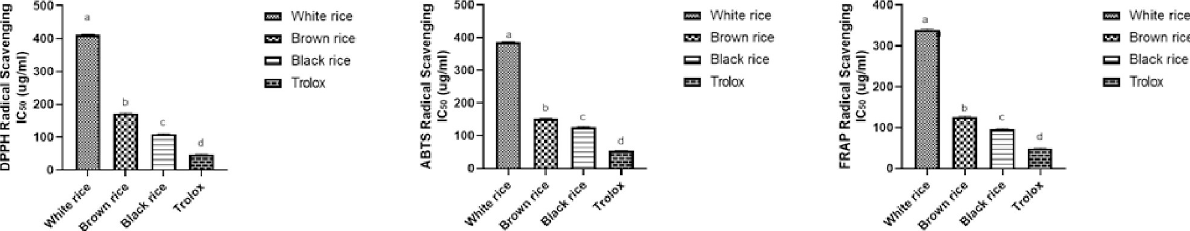
Fig 1. Ethanol extracts from rice cultivars have antioxidant properties. DPPH radical scavenging IC 50 values, ABTS radical scavenging IC 50 values, and FRAP radical scavenging IC 50 values. A minimum of three analyses were carried out. Significant differences are indicated by different lower case letters (p <